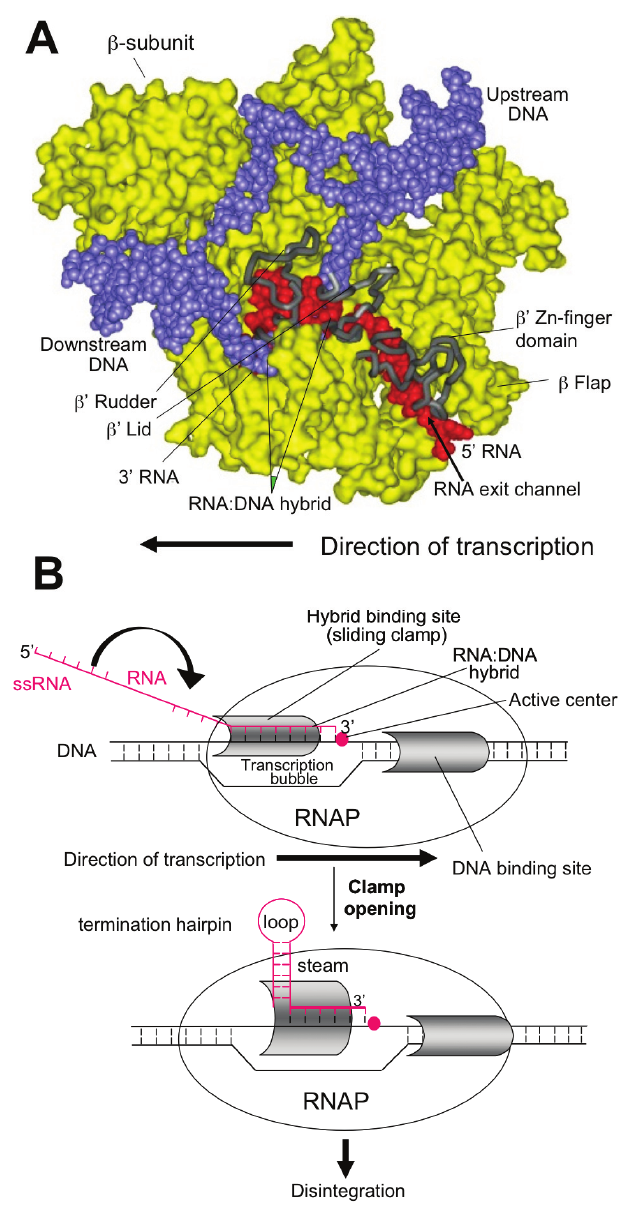
Figure 1. Model of Intrinsic